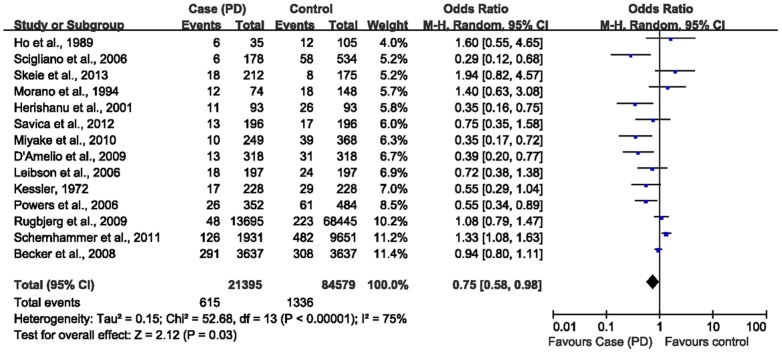
Forest plot of diabetes and risk of Parkinson's disease.